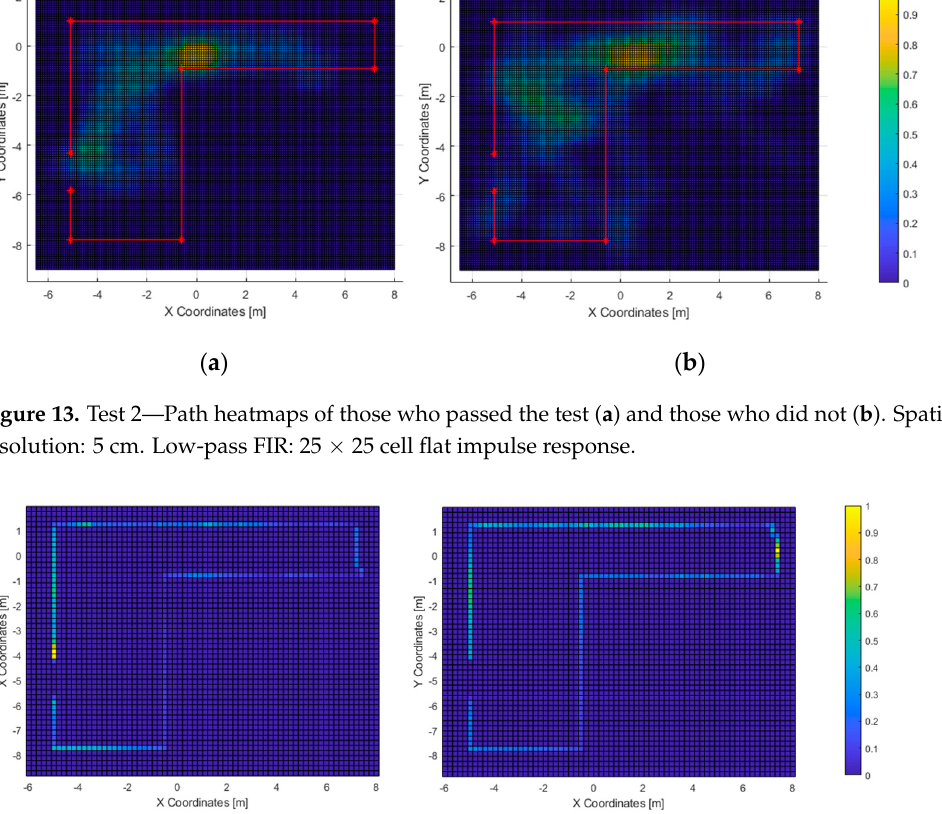
Figure 12. Test 2—Path heatmaps of those who passed the test ( a ) and those who did not ( b ). Spatial resolution: 5 cm. Low-pass FIR: 9 × 9 cell flat impulse response.